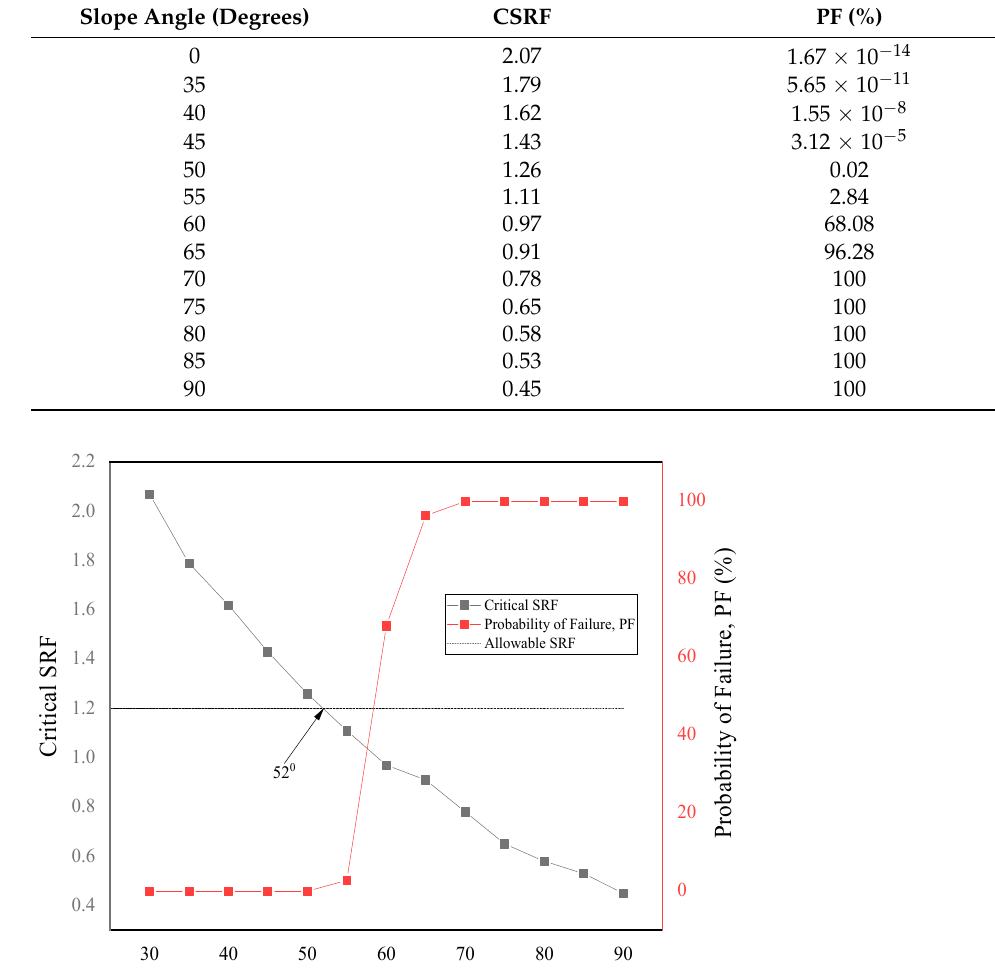
Table 2. Slope angle optimization.